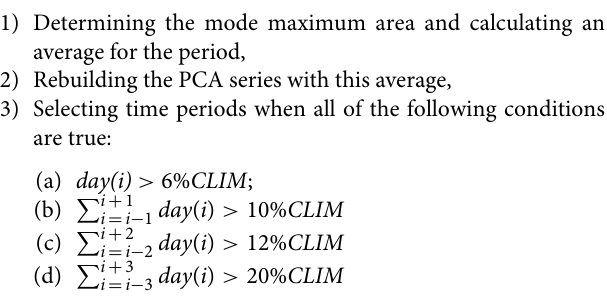
shows the coincidence area. (A) Event 10 – January, (B) Event 12 – March, (C) Event 14 – November, (D) Event 15 – February, (E) Event 22, December and (F) Event 24,